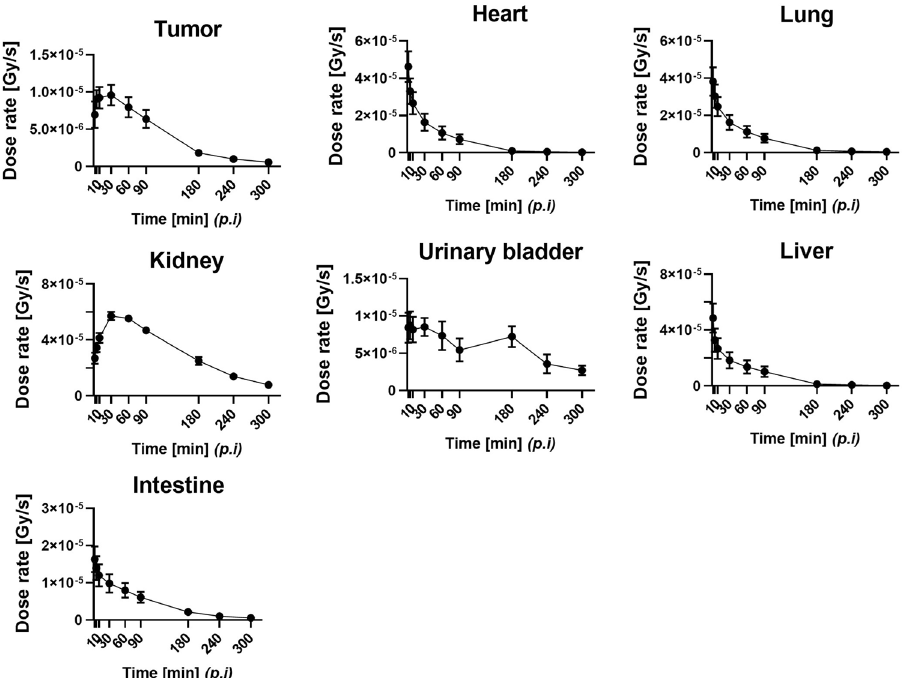
Figure 4. Dose rate curves of [ 68 Ga]PSMA-11 in the PSMA-positive tumor (22Rv1) and various organs. Values are the mean ± SEM ( n =